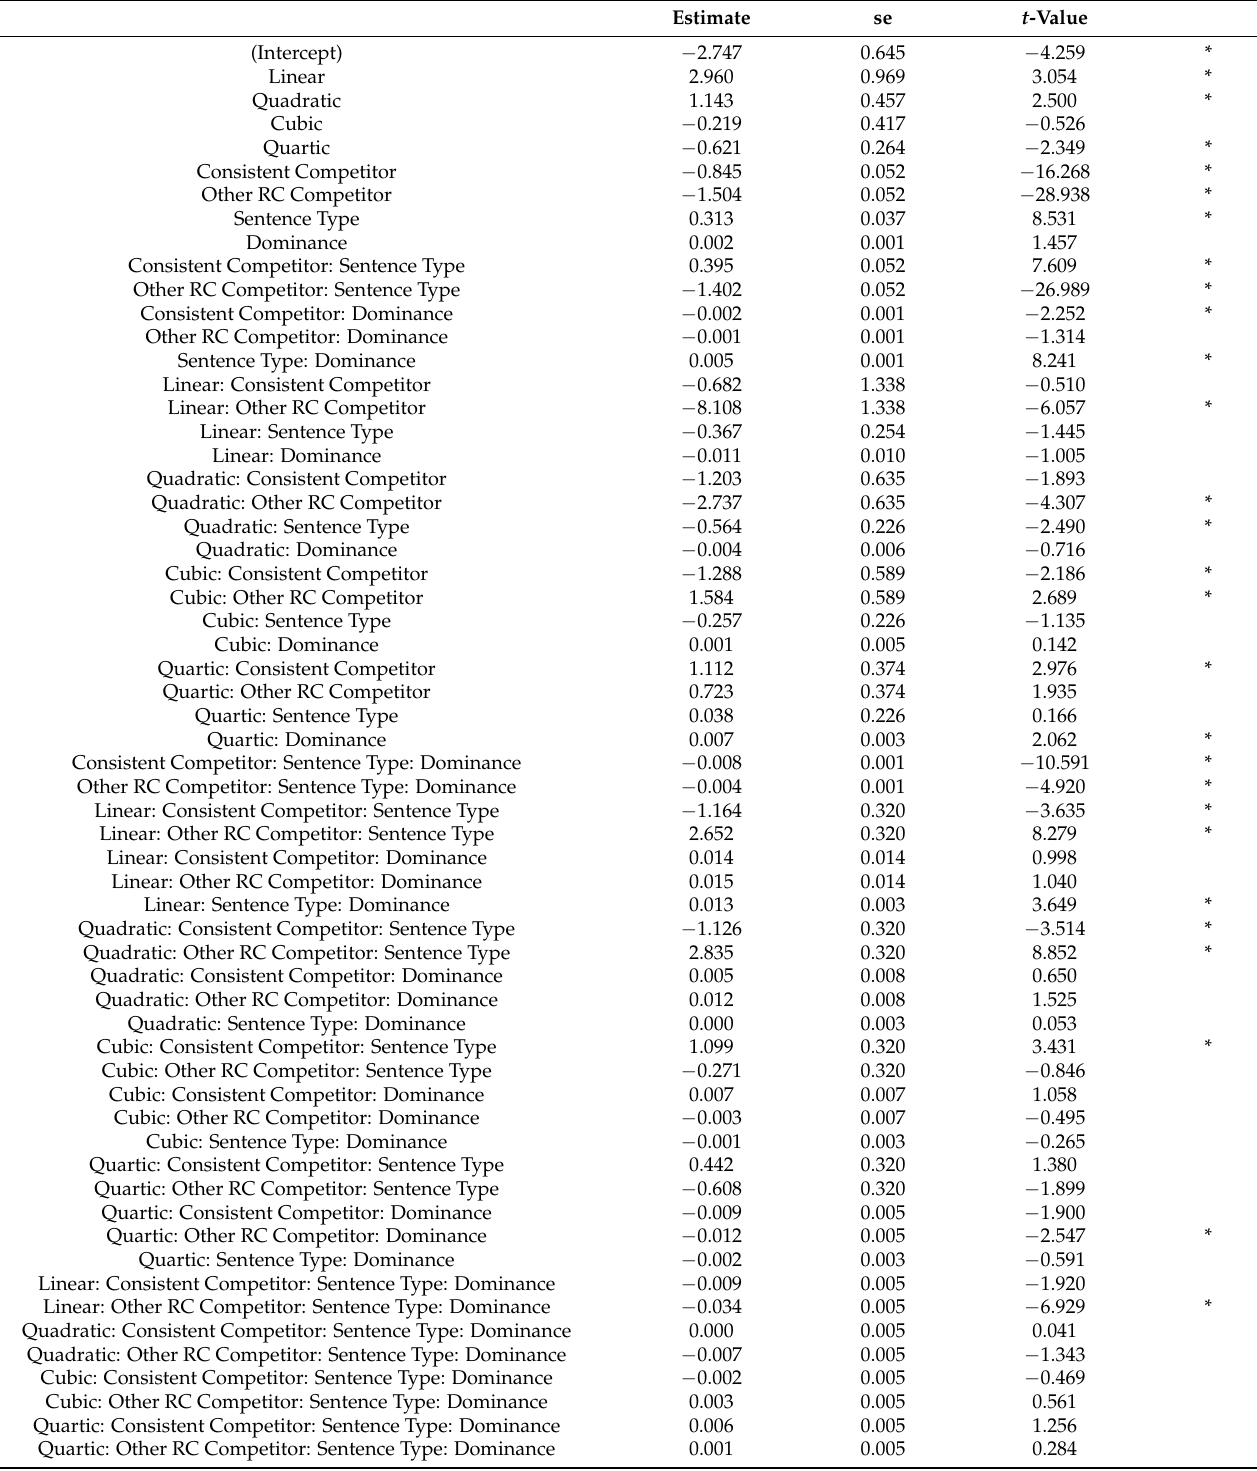
Table A2. Main and interaction effects in the quasi-logistic GCA mixed-model analysis for the relative clause region.